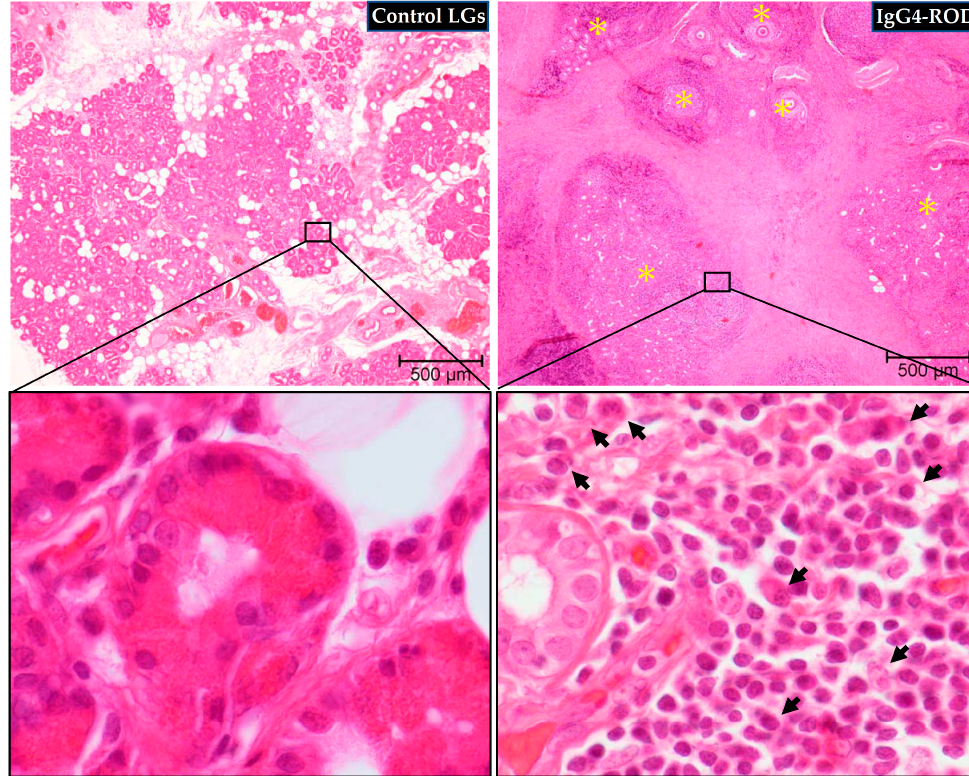
Figure 1. Representative images of hematoxylin and eosin (H&E) staining of the LGs obtained from patients with IgG4-ROD and patients diagnosed with severe canalicular obstruction yet normal LGs as a control. Glandular structure was maintained in the normal control LGs, while completely destroyed in the LGs of the IgG4-ROD patients. Yellow asterisks indicate the area of lymphocytic hyperplasia. Black arrows indicate plasma cells.